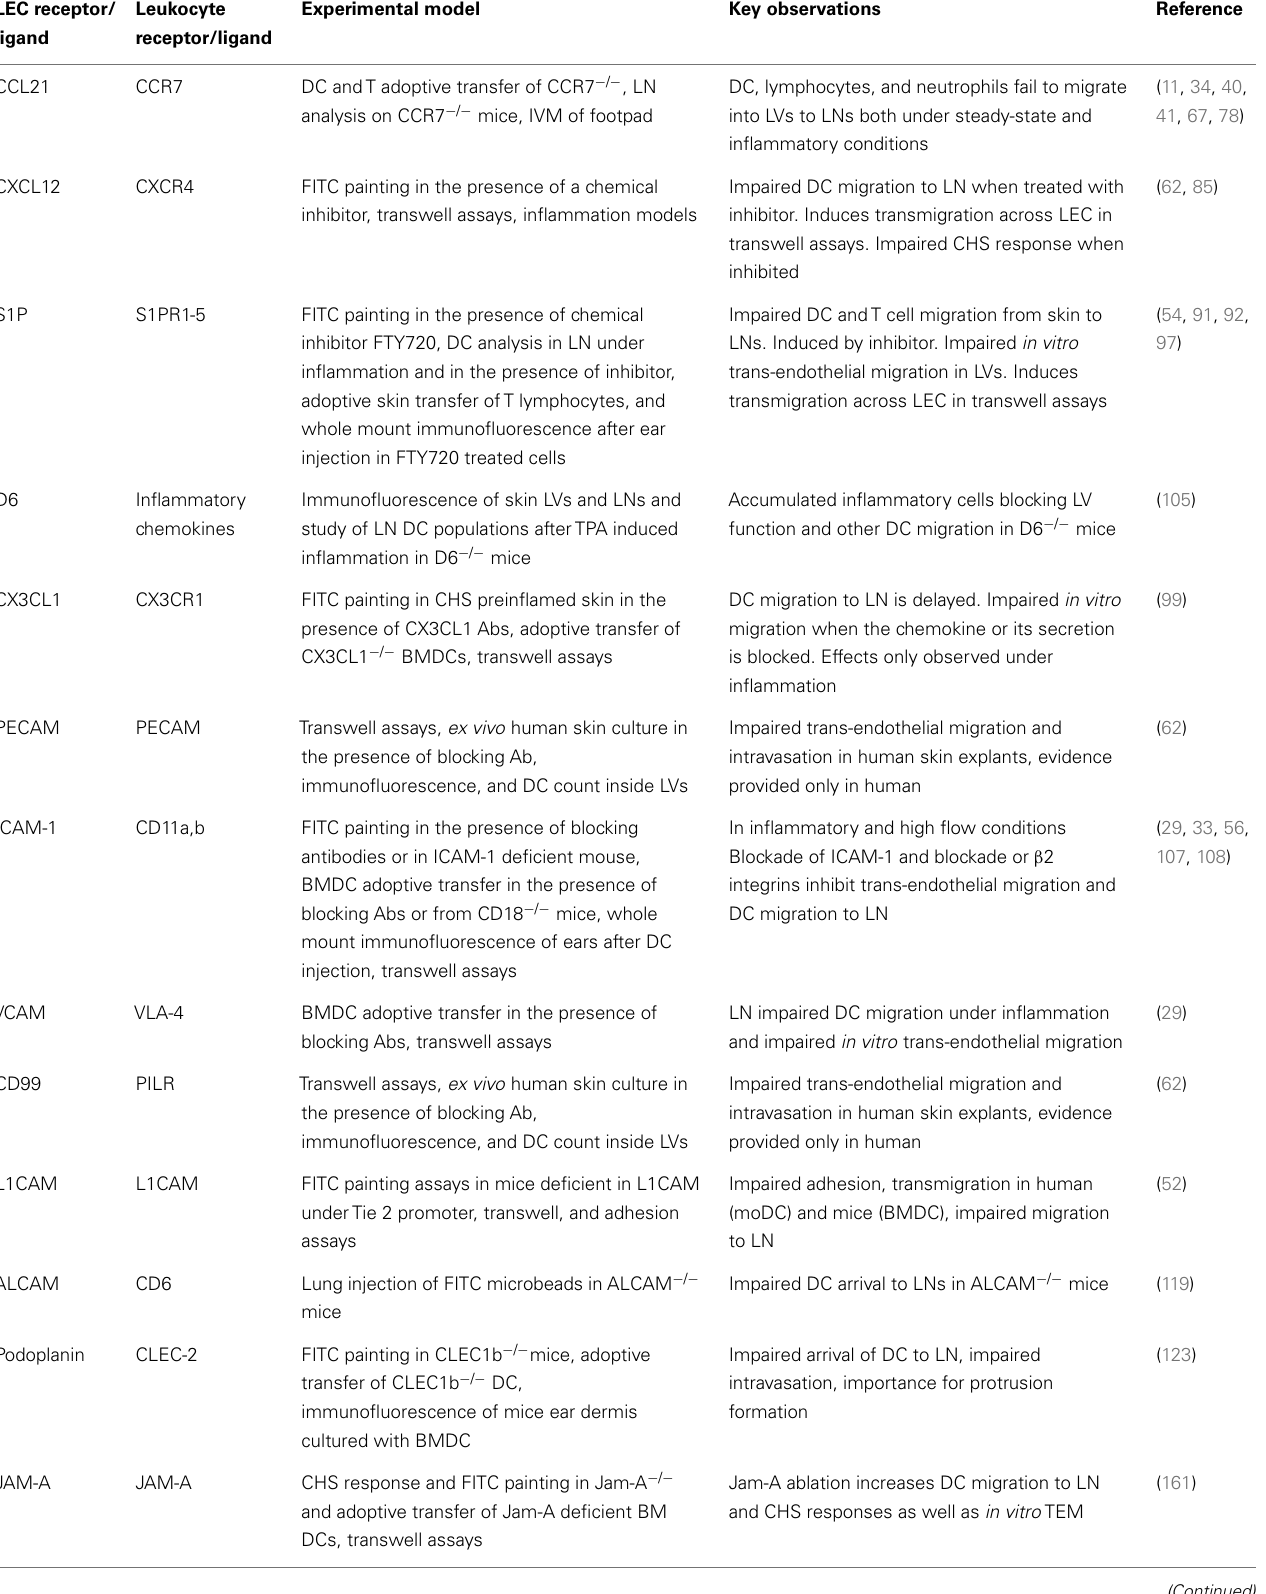
Table 1 | Summarizing table of the main molecular players described in Leukocyte traffic through LVs . LEC receptor/